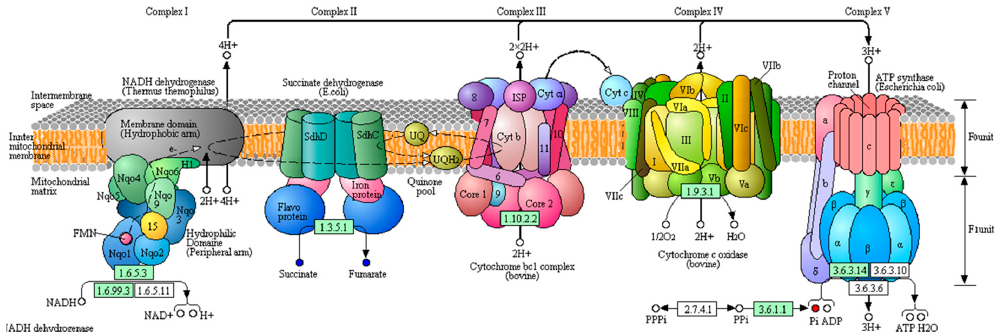
Figure 4. Differential metabolites between T6_F vs. T6_C are located in oxidative phosphorylation. Red dots indicate upregulated in oxidative phosphorylation and blue dots indicates downregulated in oxidative phosphorylation. The originated figure from KEGG pathway database.